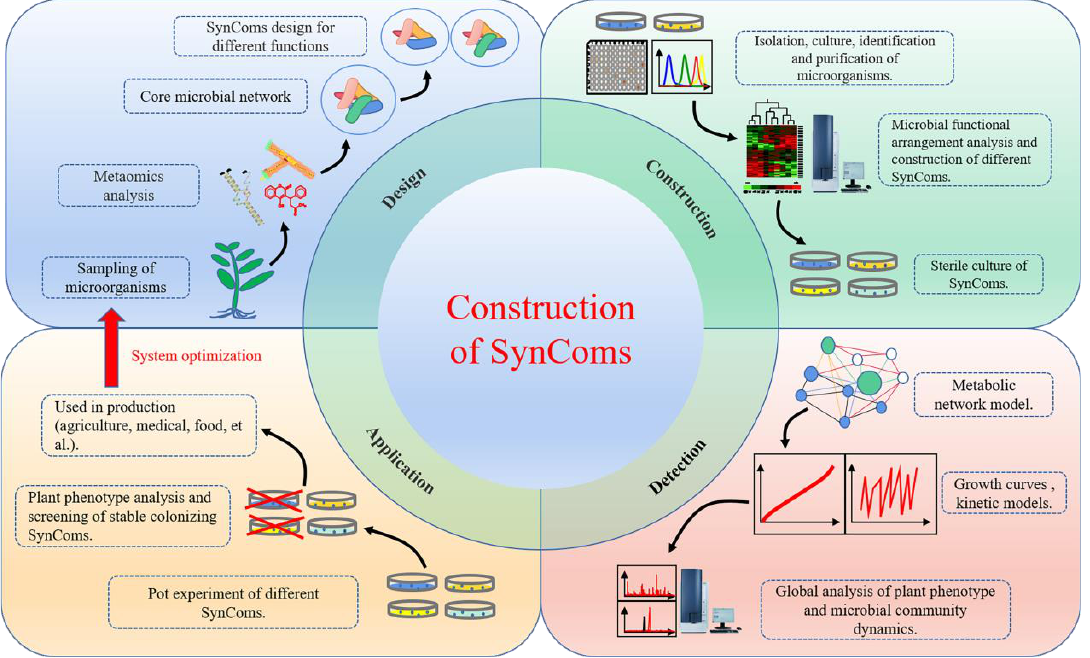
Figure 4. Construction of SynComs. SynComs with specific functions are formed by the recombina- tion of microorganisms with different functions, depending on the needs of the plant. Functional analysis of the recombinant microbial community was performed using an omics approach. Core microbial communities that can play a stable and efficient role in plant growth and development, synthesis, and accumulation of secondary metabolites can be screened for commercial mass produc- tion. The function and composition of the SynComs were also optimized through practice.